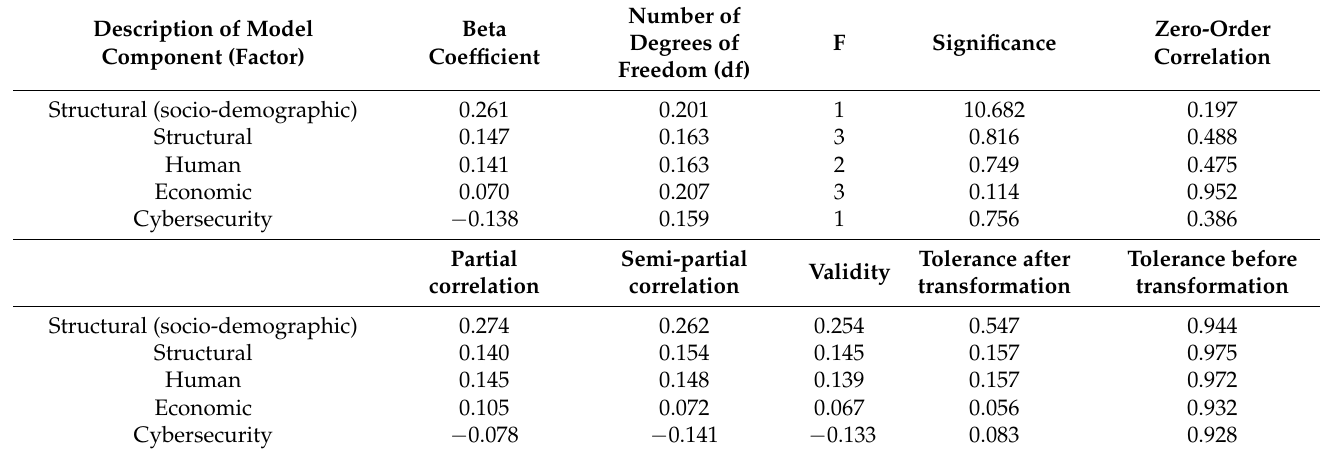
Table 12. Components of the optimal scaling model obtained by the descending